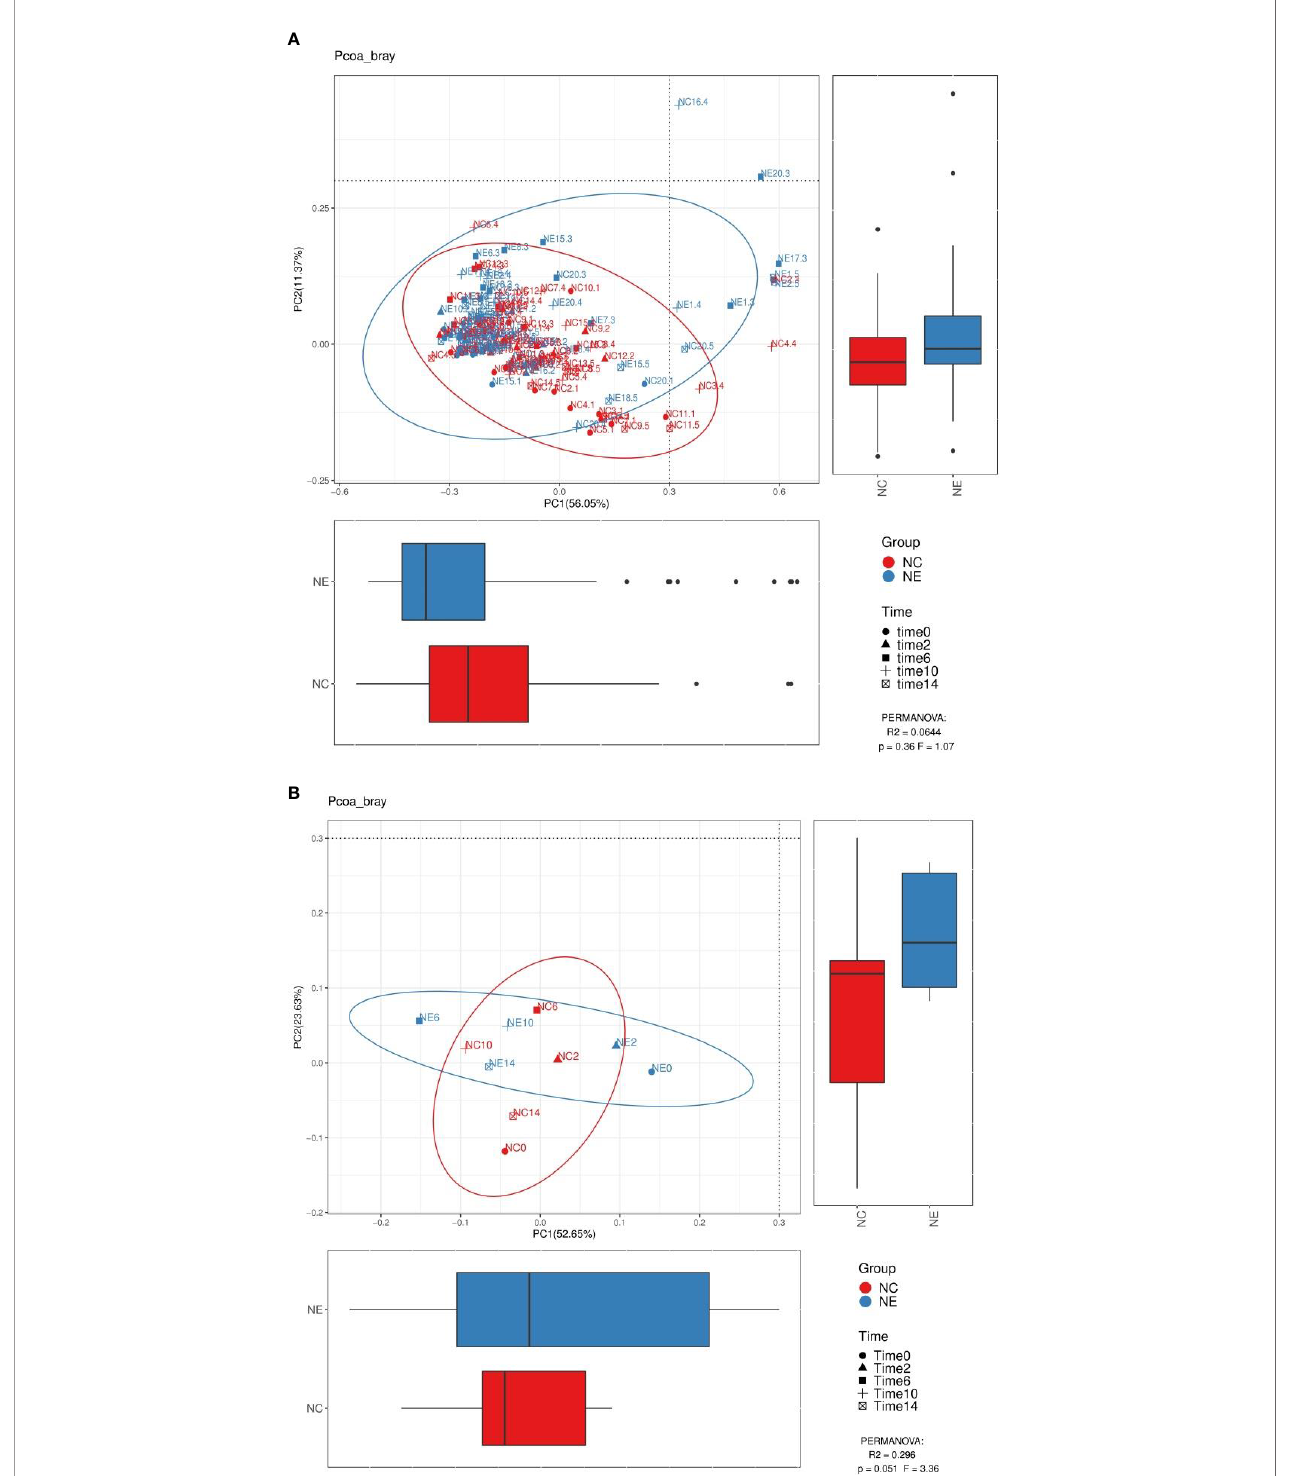
FIGURE 9 | Analysis diagram of principal coordinate analysis (PCoA) at the genus level. We performed PCoA analysis based on Bray-Curtis distance. Each point in (A) represents a sample, and each point in (B) represents the average of 15 samples at a point in time. The points of the same color come from the same group, and the distance re fl ects the similarity of the samples. We used PERMANOVA test to analyze the signi fi cance, p value and the F value are at the bottom right of the graph. The red represents the NC group and the blue represents the NE